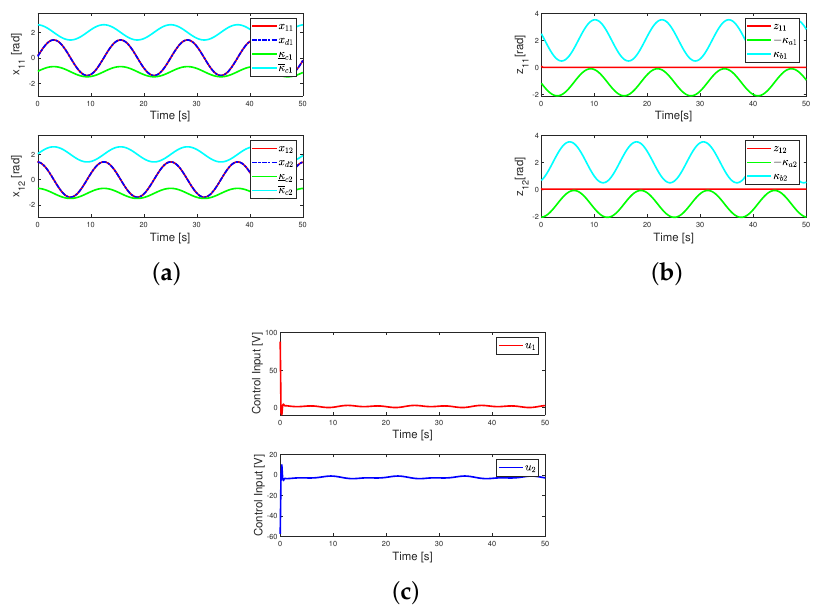
Figure 4. The control performance. ( a ) tracking performance of x 1 ; ( b ) tracking error: z 1 ; ( c ) control input: u